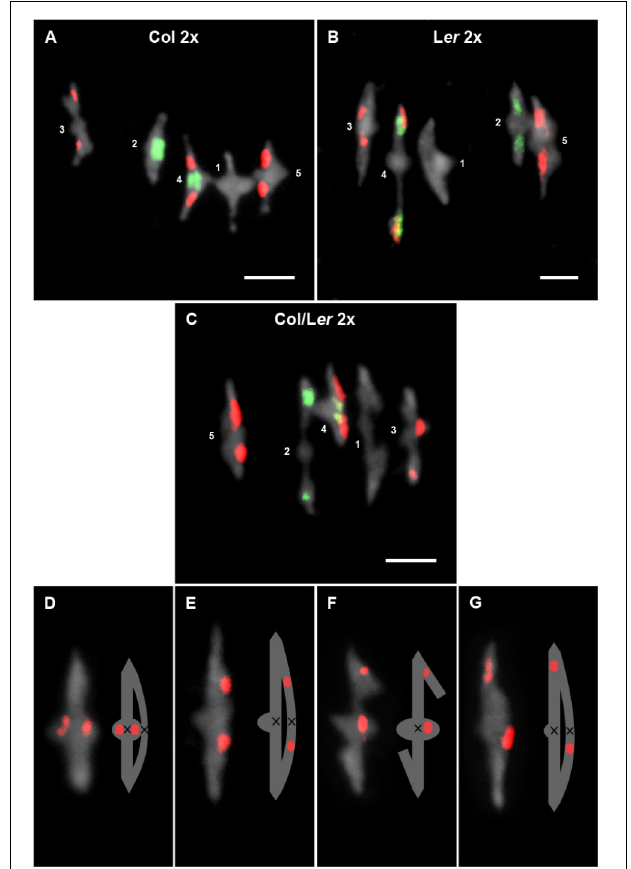
FIGURE 2 | Cytological analysis of diploid cells at metaphase I. Representative examples of metaphases I from Col 2x (A) , L er 2x (B) , and Col/L er 2x (C) . Chromosomes are identified by FISH with 5S (red) and 45S rDNA (green) probes. Images and representations of bivalents formed by chromosomes 3 in which the chiasma (black cross) has been formed before ( D,F ) or after ( E,G ) the position of the 5S rDNA in a L er ( D,E ) and in a Col/L er ( F,G ) background. Bars represent 5 µ